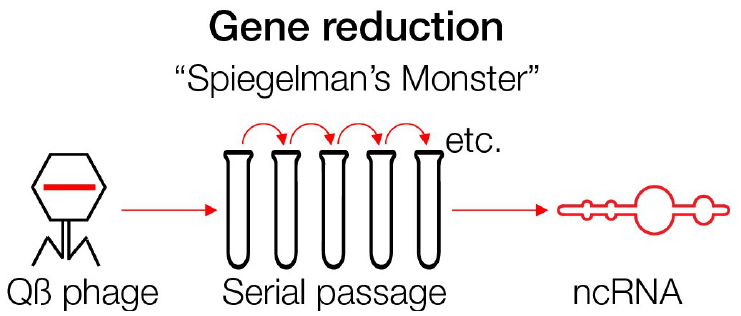
Figure 4. Gene reduction from long coding phage Q β RNA to non-coding RNA by serial passages (simplified model).